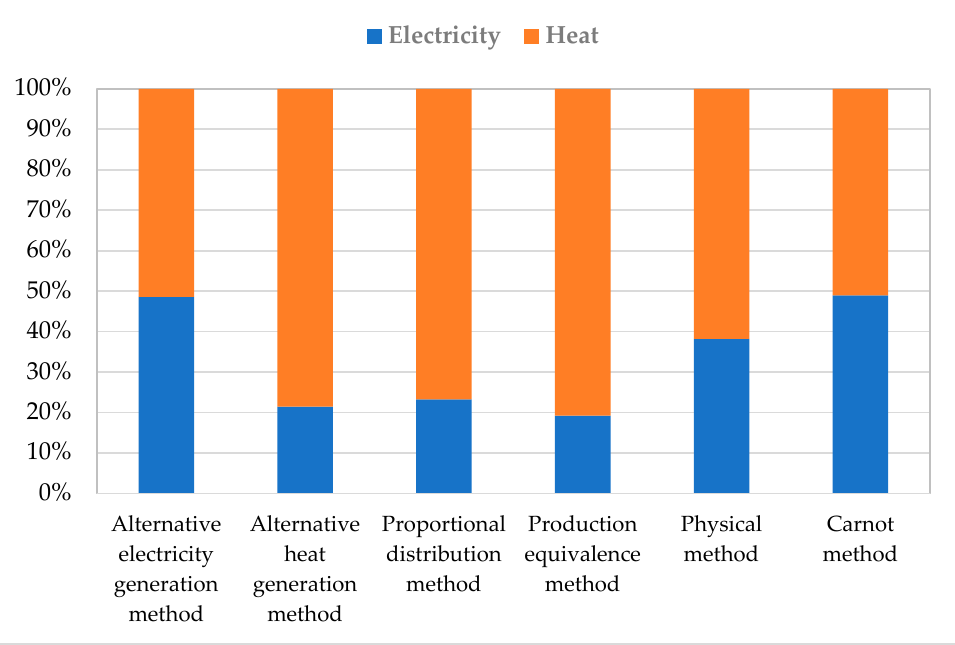
Figure 4. Distribution of fuel consumption between heat and electricity using different allocation methods.